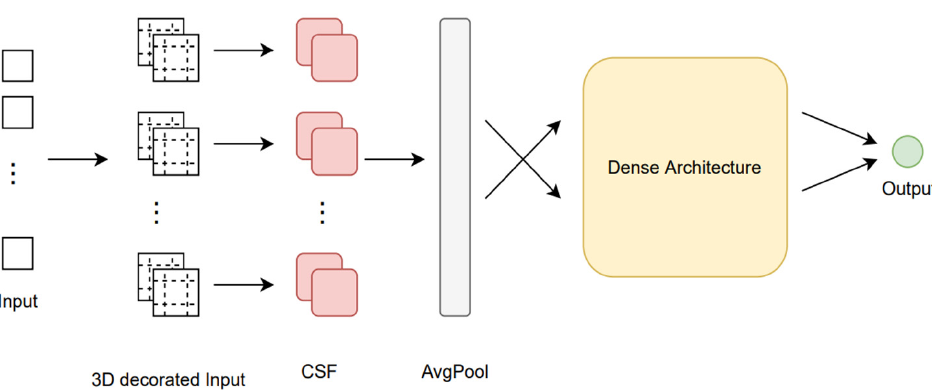
Figure 23. Cross-Space-Fusion aggregation network diagram.